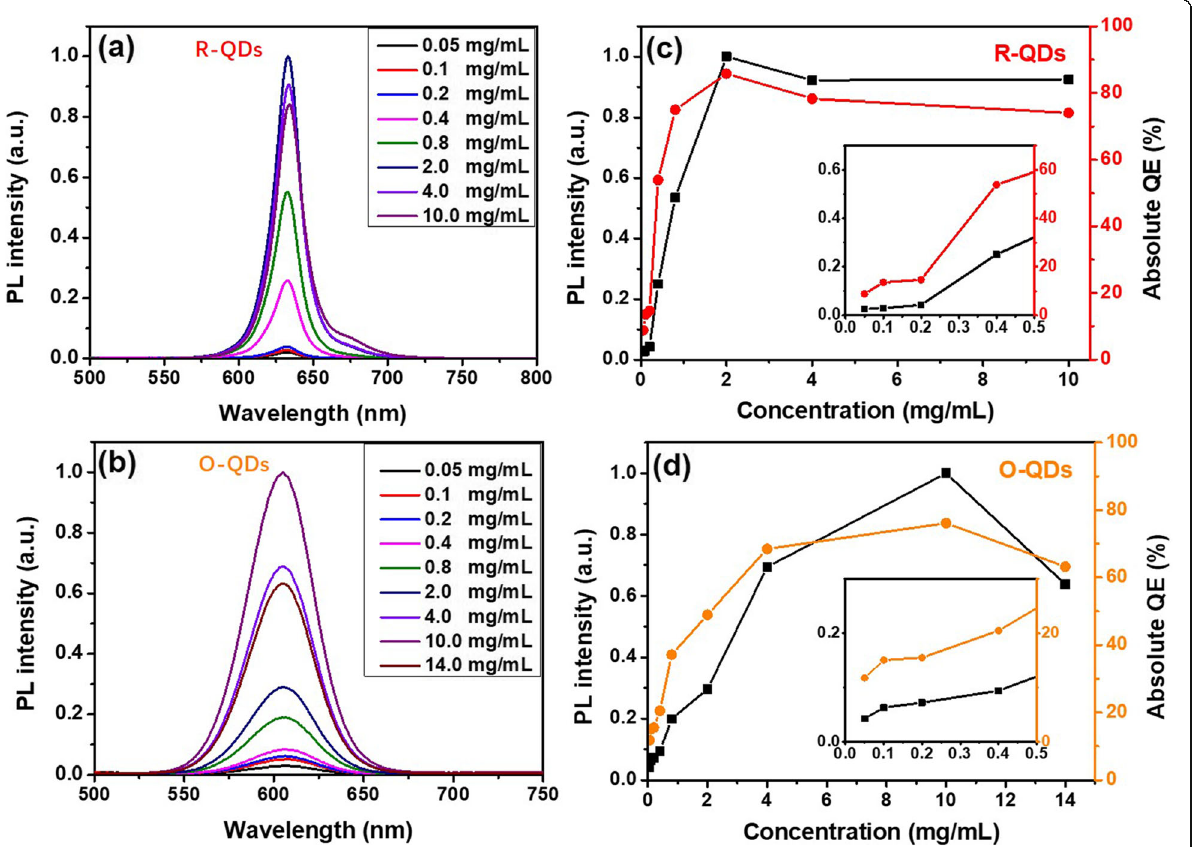
Fig. 2 PL spectra of R-QD ( a ) and O-QD ( b )-based silicone gel thin films. Corresponding PL intensity and QE of R-QD ( c ) and O-QD ( d )-based silicone gel thin films with different concentrations of